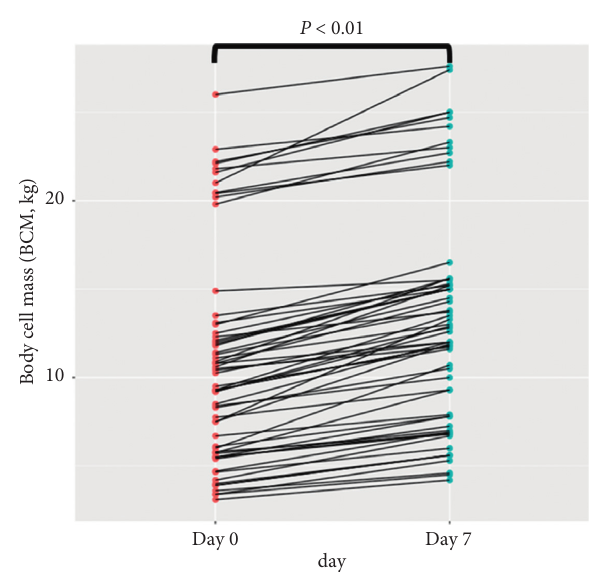
Figure 1: Demonstration of body cell mass, measured by BIA, on Day 7 of PICU admission. The BCM on Day 7 was not decreased compared with the first day of PICU admission (Wilcoxon signed- rank test, p < 0 . 01). BCM, body cell mass; BIA, bioelectrical im- pedance analysis; PICU, pediatric intensive care